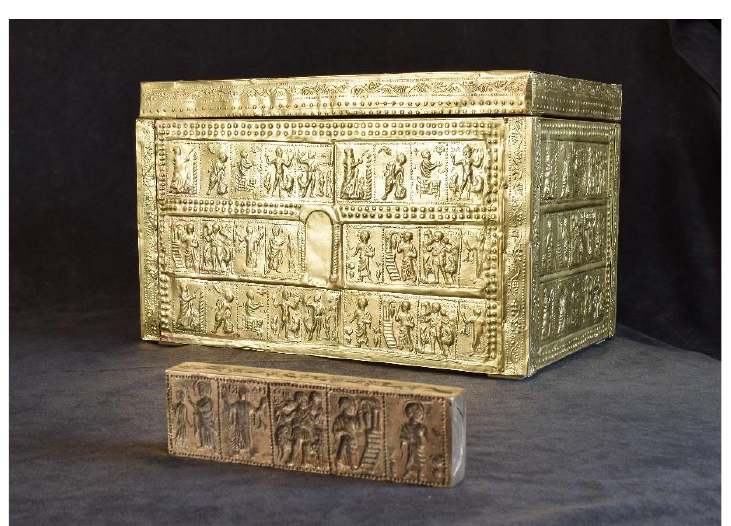
Figure 8. Presentation of a chest made of brass, where the sheet is glued to Plexiglas for the needs of the reconstruction of the existing chest in the Zadar Museum (Croatia). the reconstruction of the existing chest in the Zadar Museum